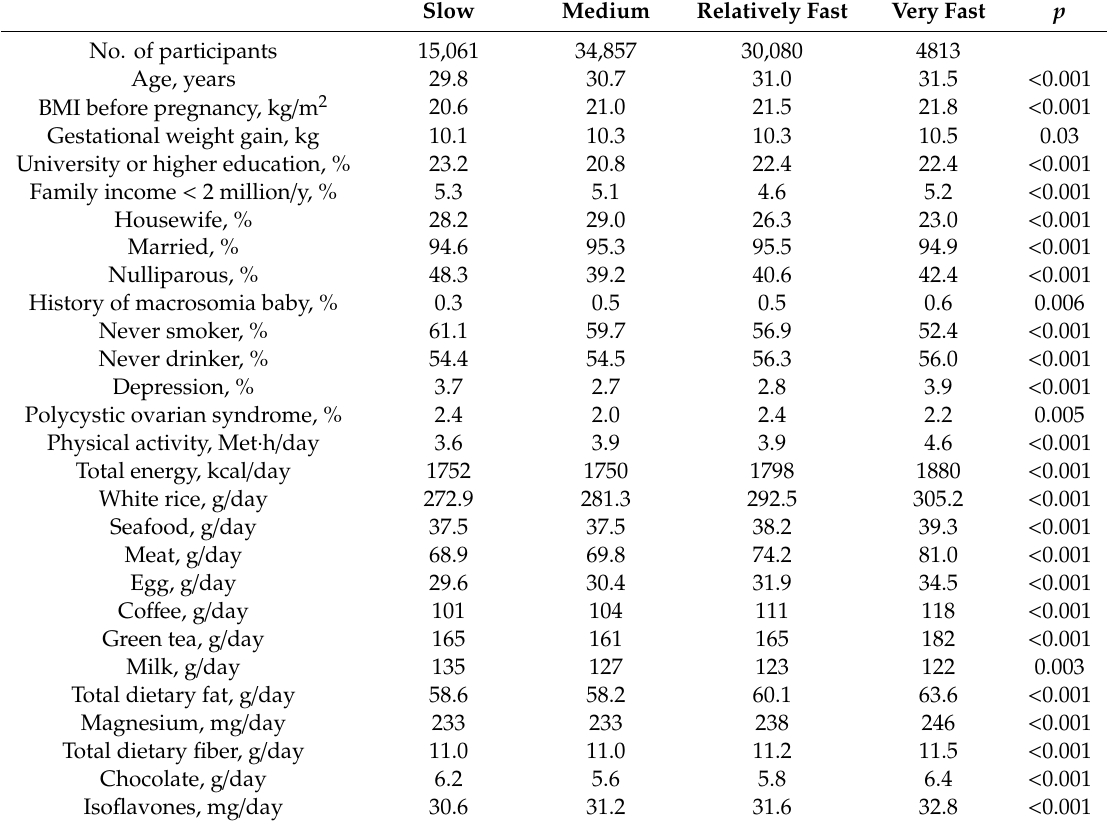
Table 1. Characteristics of 84,811 pregnant women according to self-reported eating